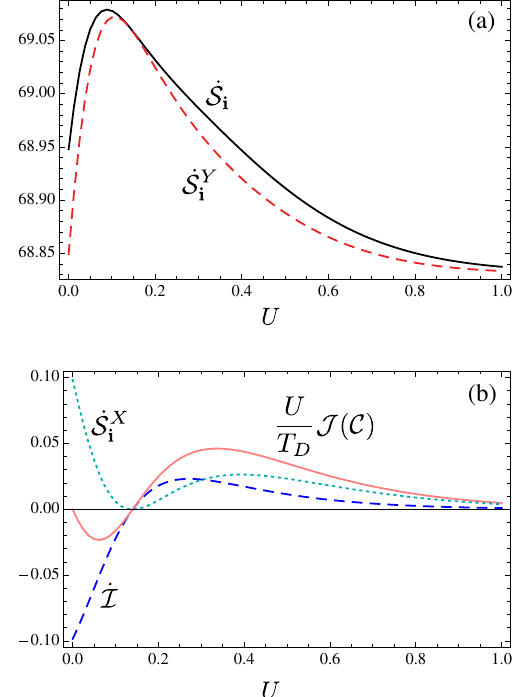
FIG. 5. Feedback cooling: (a) Plot of total entropy production _ S i (solid black line) and entropy production in the lower dot (dashed red line) as well as (b) information flow line), entropy production in the cooled upper dot line), and energetic current U J ð C Þ =T D (solid red line) flowing into the reservoir in contact with the upper dot as a function of the interaction energy U . Parameters: μ D ¼ 1 − U= 2 , μ L ¼ 0 , μ R ¼ 3